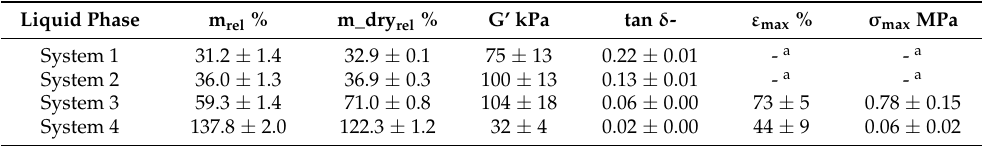
Table 1. Swelling ratios and mechanical properties obtained in the swelling studies by oscillatory rheometry and uniaxial compression of hydrogel discs. All measurements were performed at room temperature (22 ◦